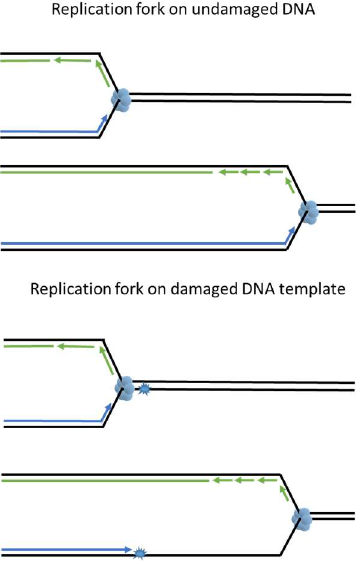
Figure 2. DNA lesions in single stranded DNA (ssDNA) are detrimental to the replication fork. DNA lesions on an ssDNA template act as road blocks for replicative polymerases but not for the replicative DNA helicase. An uncoupling of replicative DNA polymerase and DNA helicase activities generates single stranded DNA tracts. Persistent ssDNA is fragile and prone to breakage, generating lethal DSB.